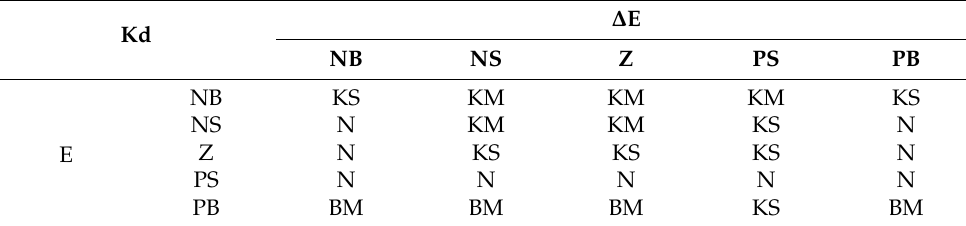
Table A3. Fuzzy-PID Tuning Rules for Constant